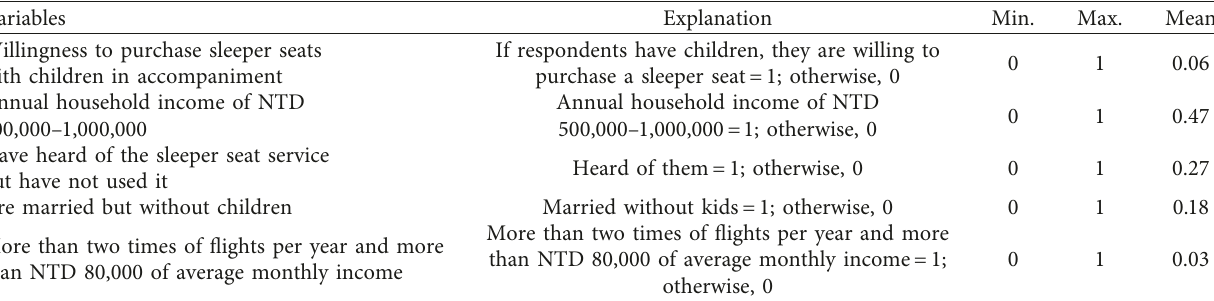
Table 6: Significant variables included in the model.